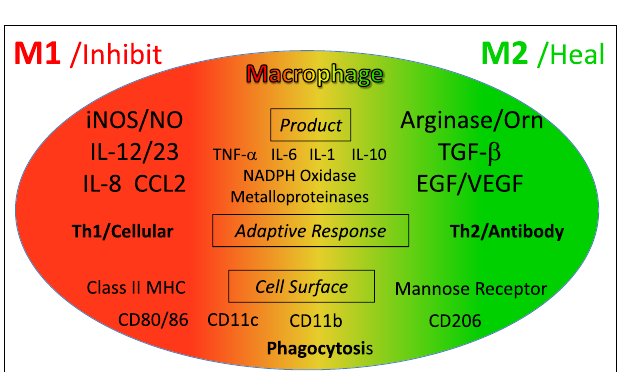
FIGURE 8 | Macrophages initiate and direct other immune responses . For example, M1-type responses (e.g., through IL-12 and antigen presentation) direct T cells to become cytolytic T cells and produce IFN- γ that further elevates